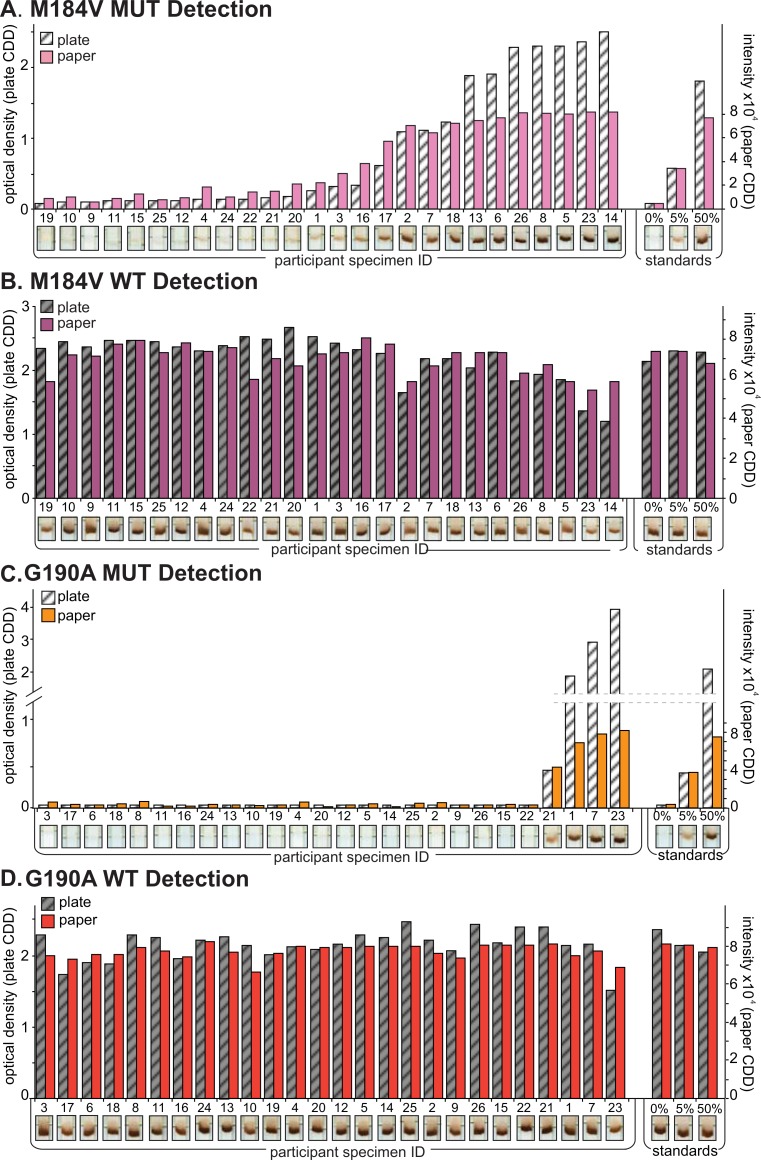
Analysis of clinical specimens and plasmid standards by paper capture, denaturation, and detection (CDD) and plate CDD for mutations M184V and G190A.Panels A and C show mutant (MUT) detection, and Panels B and D show wild-type (WT) detection. Sample optical density (OD) minus negative control OD (left y axis) for each specimen is shown in white/gray by rank along the x axis, from the lowest MUT OD, followed by the plasmid standards (0%, 5%, 50% MUT) performed in duplicate. Spot intensity minus background intensity (right y axis) for each specimen is shown in pink and orange bars followed by the plasmid standards (0%, 5%, 50% MUT) performed in triplicate. Scanned images of the paper CDD detection strip are shown below each specimen’s signal data.